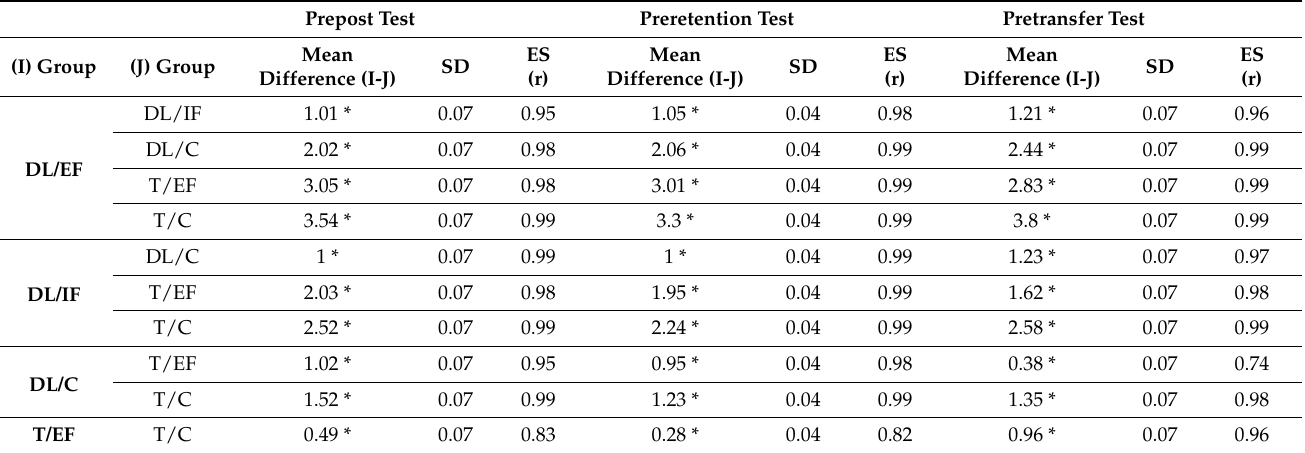
Table 4. Fisher’s least significant differences (LSDs) of averages comparing changes in pre- and post- retention and transfer tests. * Deemed to be statistically highly significant, as